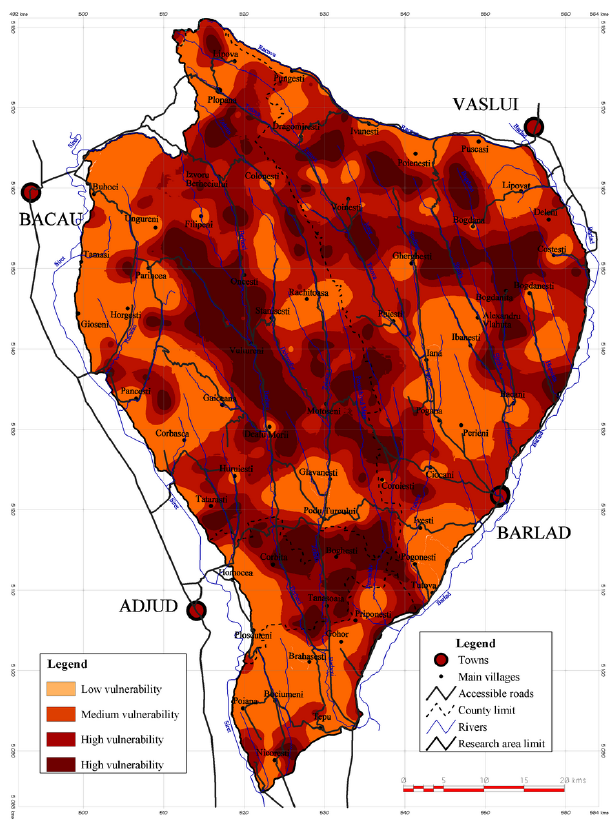
Fig. 3. Vulnerability factor 1: Size of villages (number of inhabi- tants) in Tutova